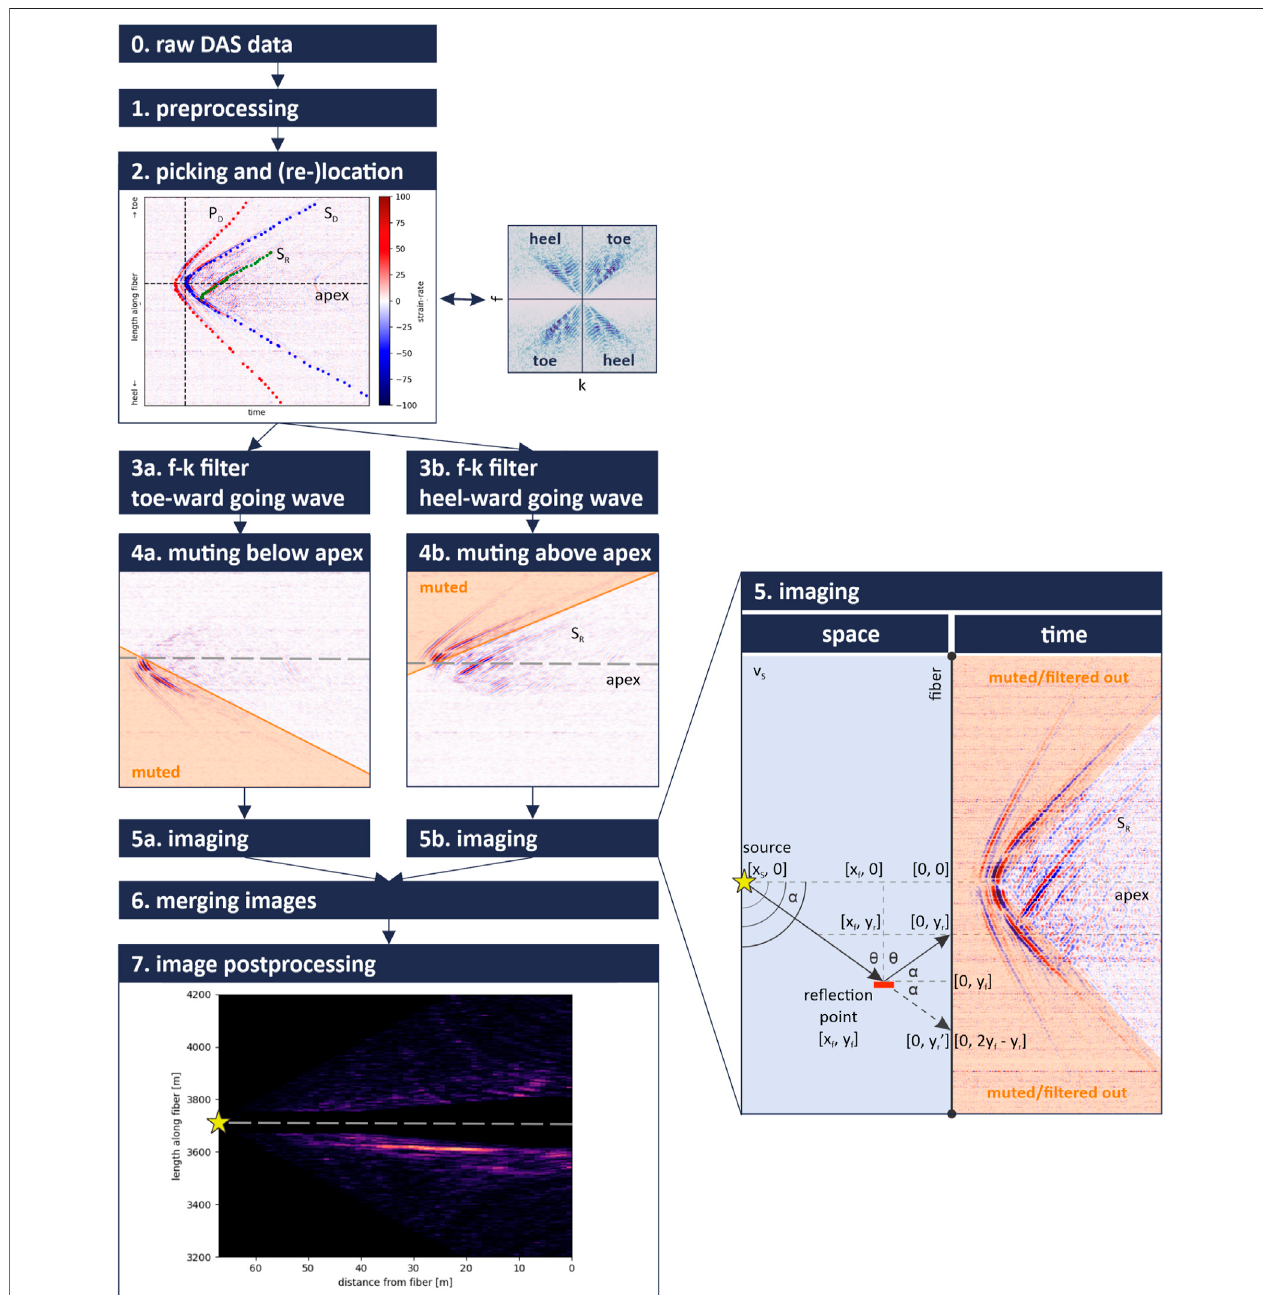
FIGURE 2 | Proposed 7-step work fl ow of re fl ector imaging using re fl ected S-waves recorded by DAS with an illustration of raytracing-based re fl ector imaging methodology.